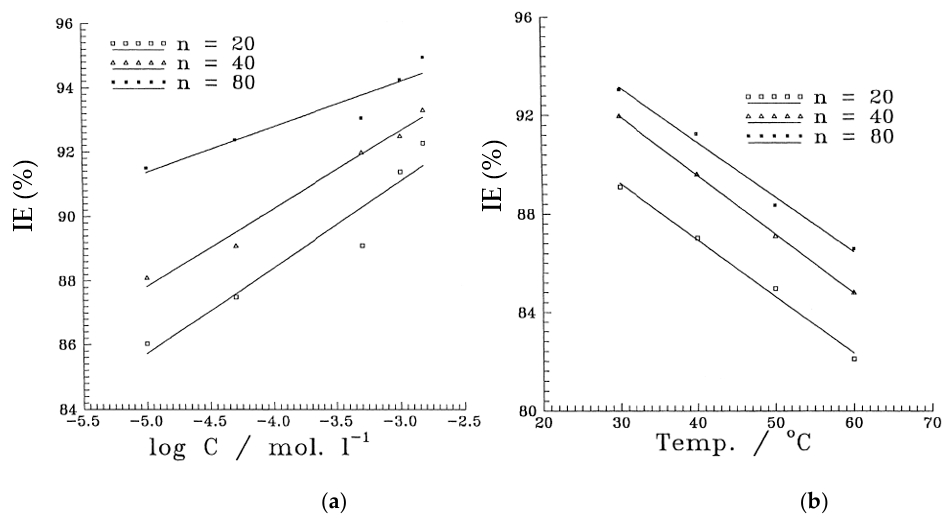
Figure 8. Variation of the protection efficiency with ( a ) the logarithmic concentrations of the inhibitors